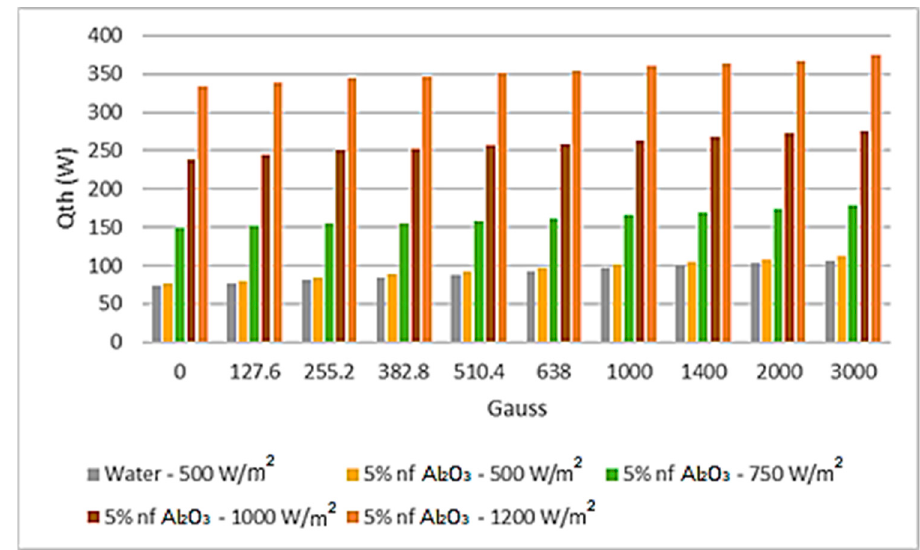
Figure 16. Thermal energy generated by PV-Th solar panels with different solar radiations.